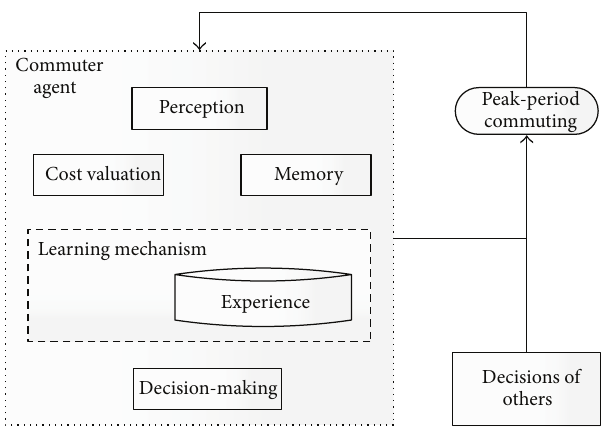
Figure 2: Commuter’s modules and its interaction with the external environment.